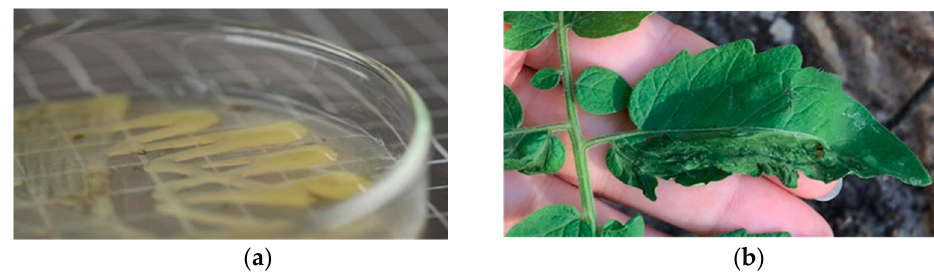
Figure 1. The yellowish bacteria X. arboricola NRCIB X8 ( a ) and hypersensitive reaction test on tomato ( b ).